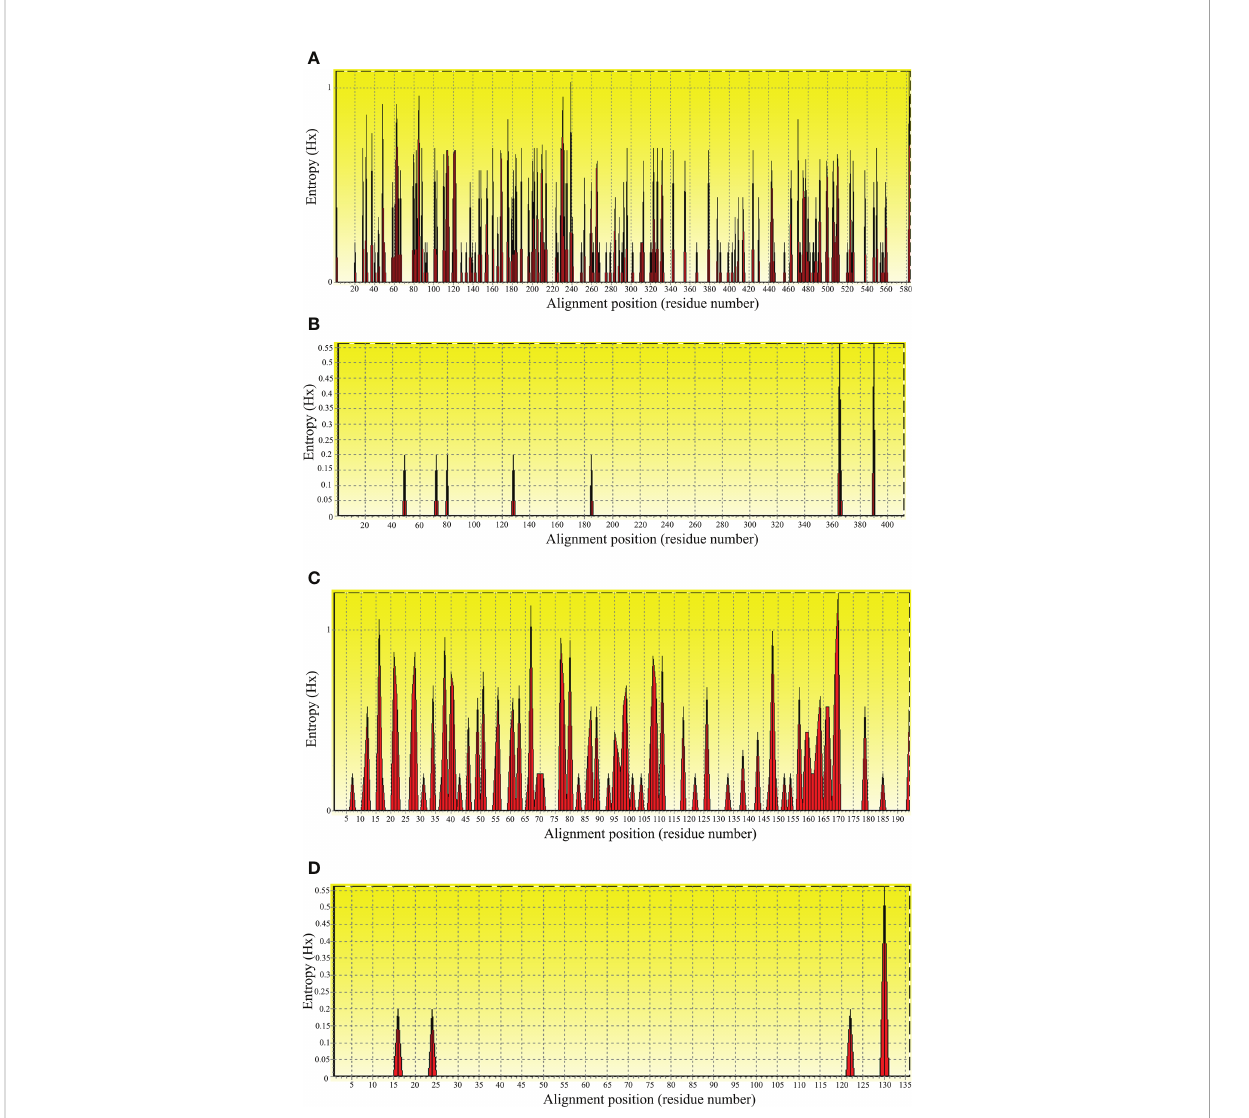
FIGURE 3 Entropy analysis of Babesia gene sequences. Entropy plot of multiple nucleic acid sequence alignment of B bovis sbp-2 (A) and B bigemina rap- 1a (B) genes. Entropy plot of multiple amino acid sequence alignment of sbp-2 (C) and rap-1a (D) . The red peaks indicate the high variation at each position of the nucleic (A, B) and amino (C, D) acid